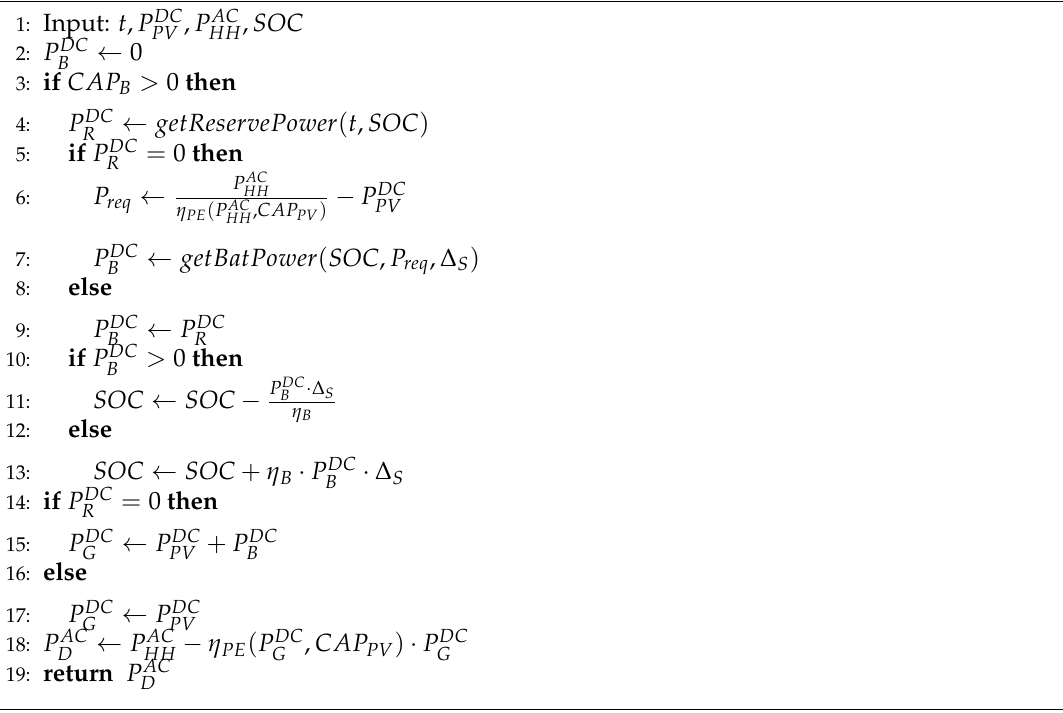
Figure 1. Algorithm of control ( t , P DC